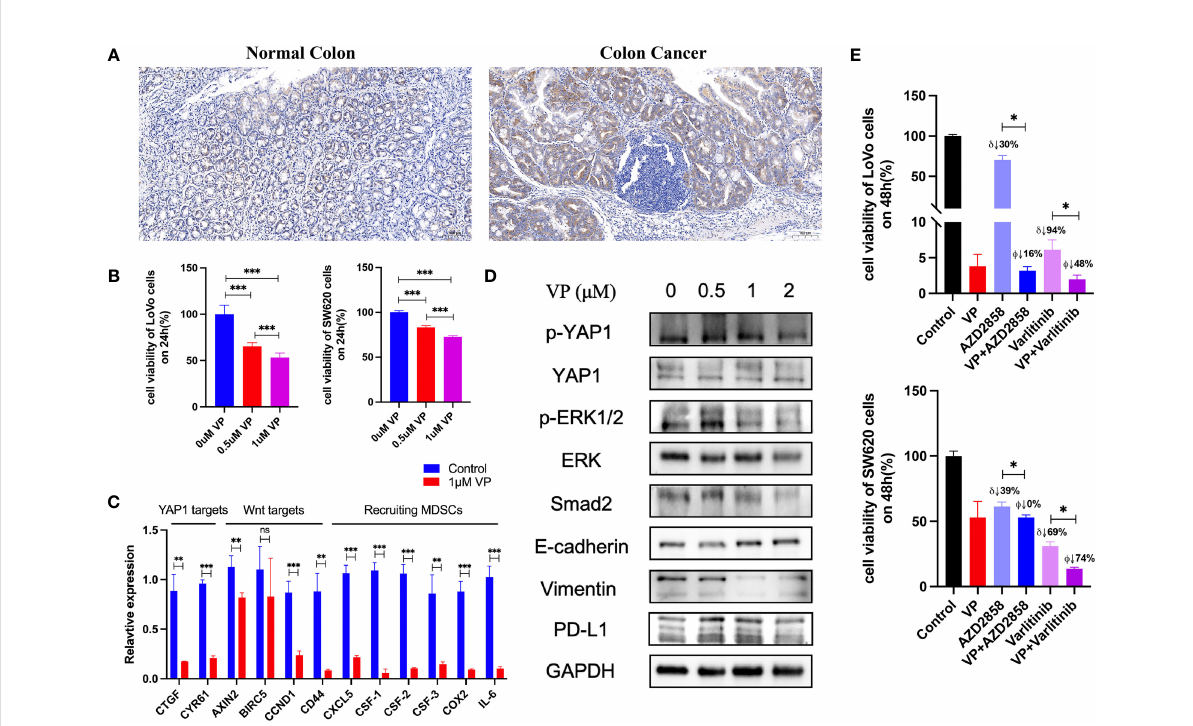
FIGURE 8 Experiments to con fi rm the activities of YAP1 . (A) IHC staining of YAP1 in normal colon tissue and AOM/DSS-induced colitis-associated CRC in C57BL/6J mice. (B) Effect of YAP1 inhibitor vertepor fi n (VP) on the viability of CRC cells (24 h). (C) Regulation of YAP1 inhibitor on Wnt target genes and chemokines that recruit MDSCs ’ in fi ltration in LoVo cell line. (D) YAP1 is involved in KRAS and TGF- b signaling pathways as well as EMT processes in Lovo cell line. (E) Effect of AZD2858 and varlitinib in combination with YAP1 inhibitor on the viability of CRC cells. d : versus control group, f versus vertepor fi n group. VP: 1 m M; AZD2858: 1 m M; varlitinib: 5 mM. ns (no signi fi cance), *p < 0.05, ** p < 0.01, and *** p <